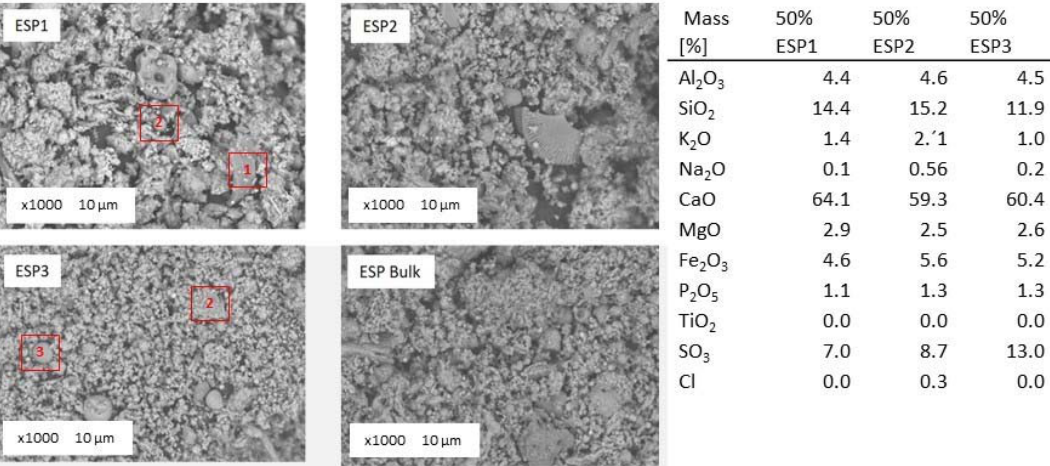
Figure 17. Backscattered electron images of fly ash from 100% thermal share Cynara combustion.